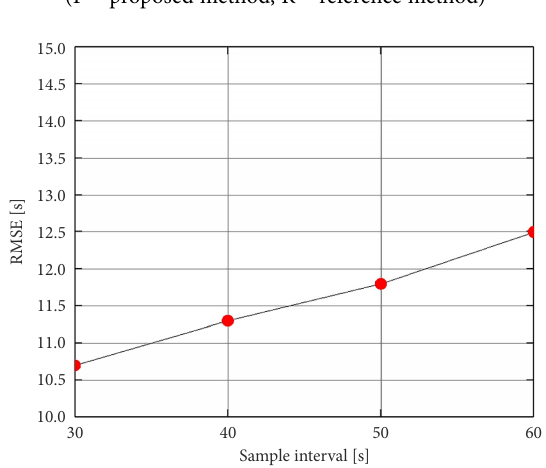
Figure 9. Sensitivity analysis with different sample